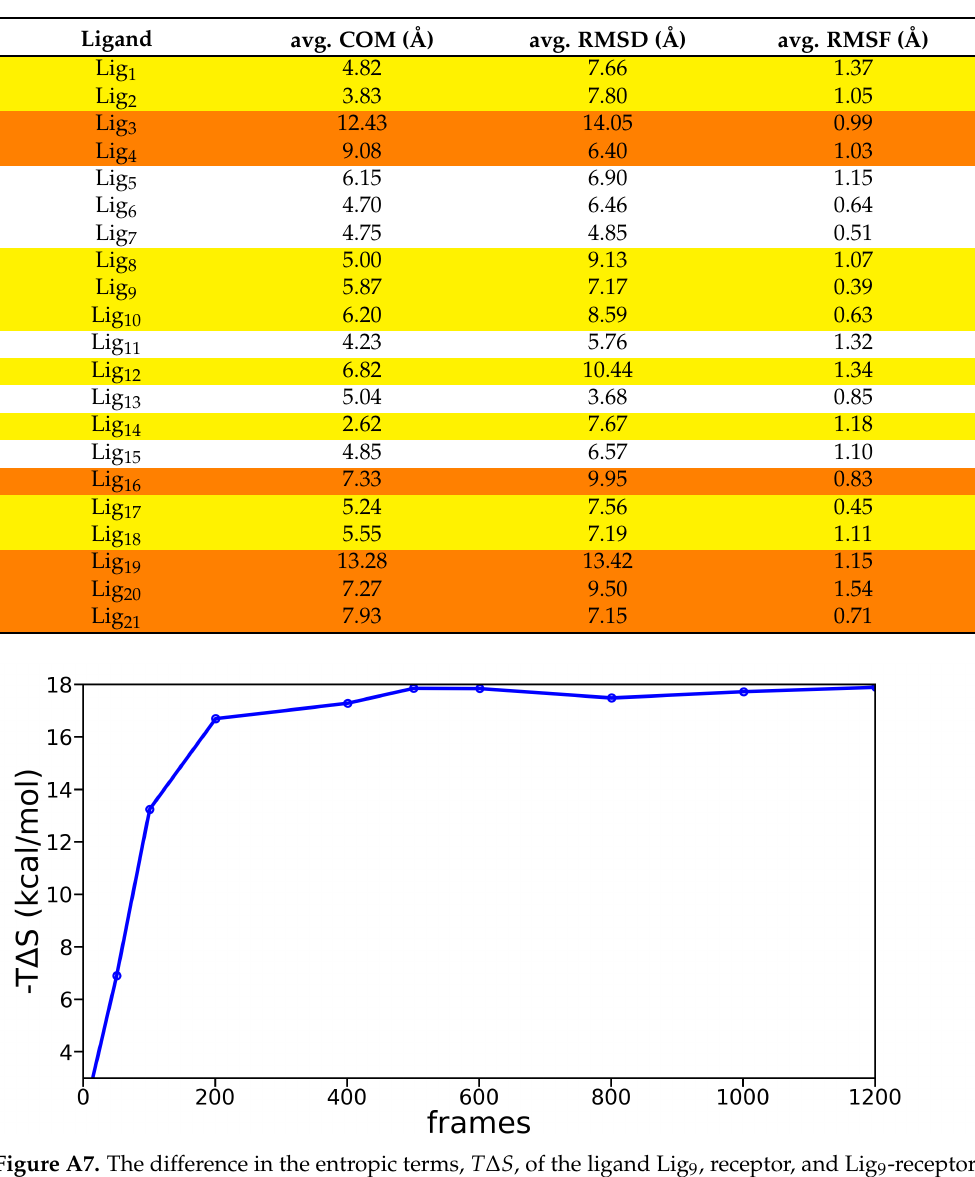
Table A3. Average COM distances between the ligands and the binding site are measured during the last 10 ns simulation of the ligand–receptor (complex) simulations. Average RMSD values of the ligands are calculated based the last 30 ns the complex simulations with the protein backbone aligned with itself. RMSF values are calculated as an average over the RMSF of each atom in the ligands throughout the 50 ns simulations of the complex. Ligands discarded due to high COM and RMSD values are highlighted in orange and yellow, respectively.